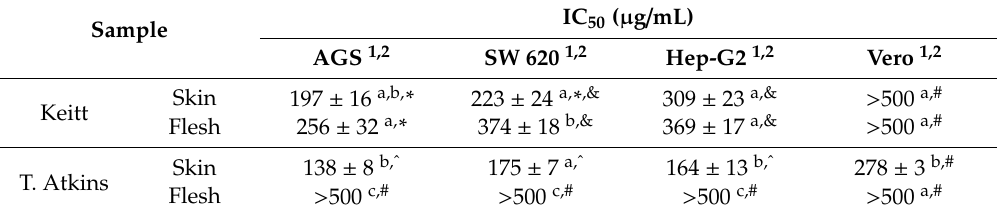
Table 4. Cytotoxicity of M. indica extracts towards gastric (AGS), colon (SW-620), and liver (Hep-G2) carcinoma cells as well as towards Vero non-tumoral